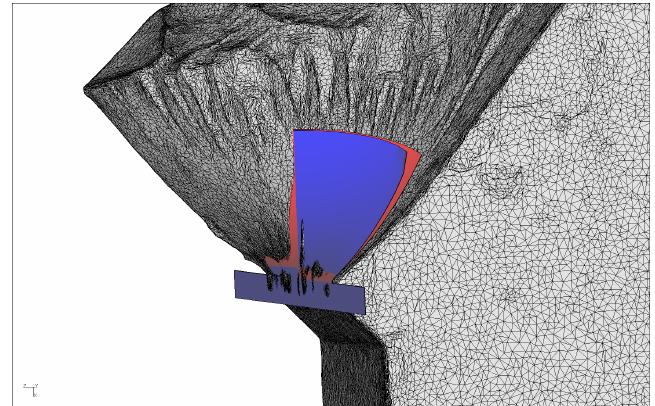
Figure 14. Specimen 0_1_00_1 experimental crack surface with the numerical prediction by the current method (in red) and the new one (in